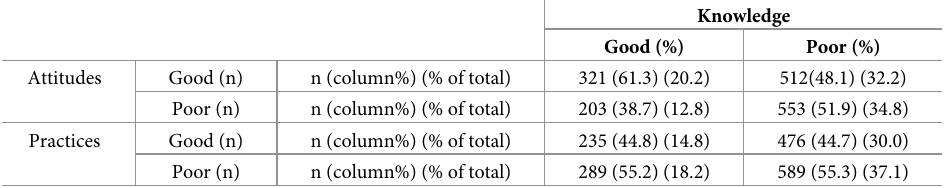
Table 6. Cross tabulation of good and poor attitudes and practices with respect to the participants’ COVID-19 knowledge status.